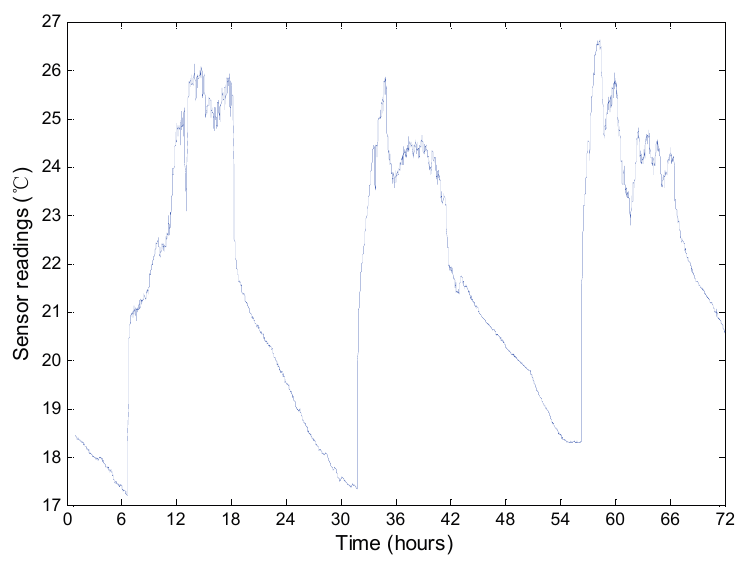
Figure 12. The temperature readings of the No.1 node from March 1st to